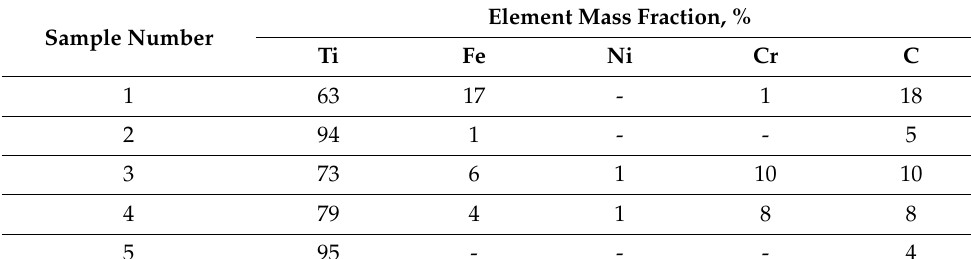
Table 1. Elemental composition of crystallites.